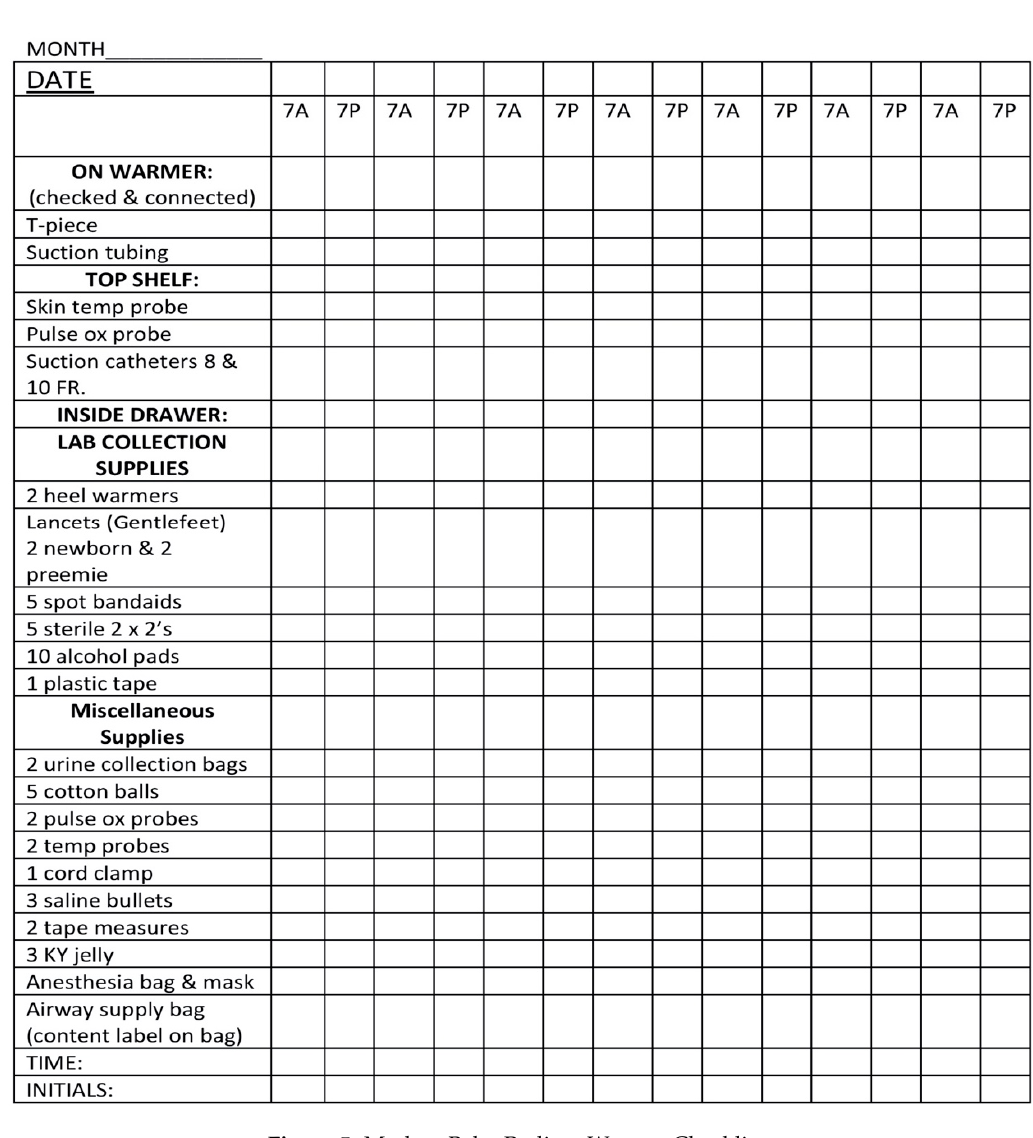
Figure 5. Mother–Baby Radiant Warmer Checklist.